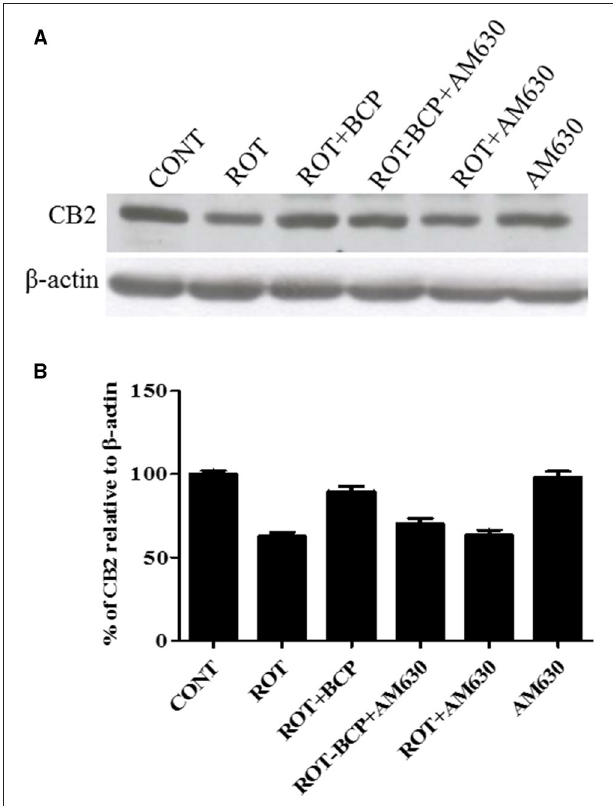
FIGURE 2 | The expression level of cannabinoid receptor 2 (CB 2 ) measured by western blot in the striatum. (A) The western blot showing CB 2 expression. (B) CB 2 expression was decreased in the ROT group as compared to the CONT group rats. However, BCP supplementation of ROT injected rats showed increased expression of CB 2 receptors. Selective antagonist of CB 2 receptors, AM630 administration prior to BCP supplementation decreased the expression of CB 2 receptors. AM630 administration to ROT injected rats has not shown any noticeable difference in the expression of CB 2 . Finally, AM630 alone had no effect on the level of CB 2 expression as compared to control rats. Values are expressed as percent (%) mean ± SEM ( n =